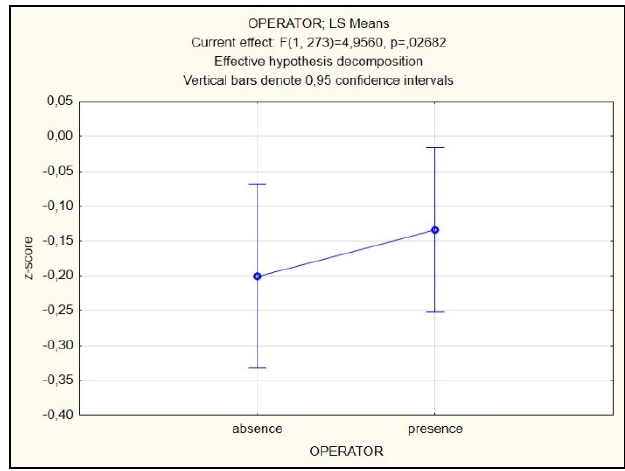
Figure 8. Strategy post hoc results (Finnish).